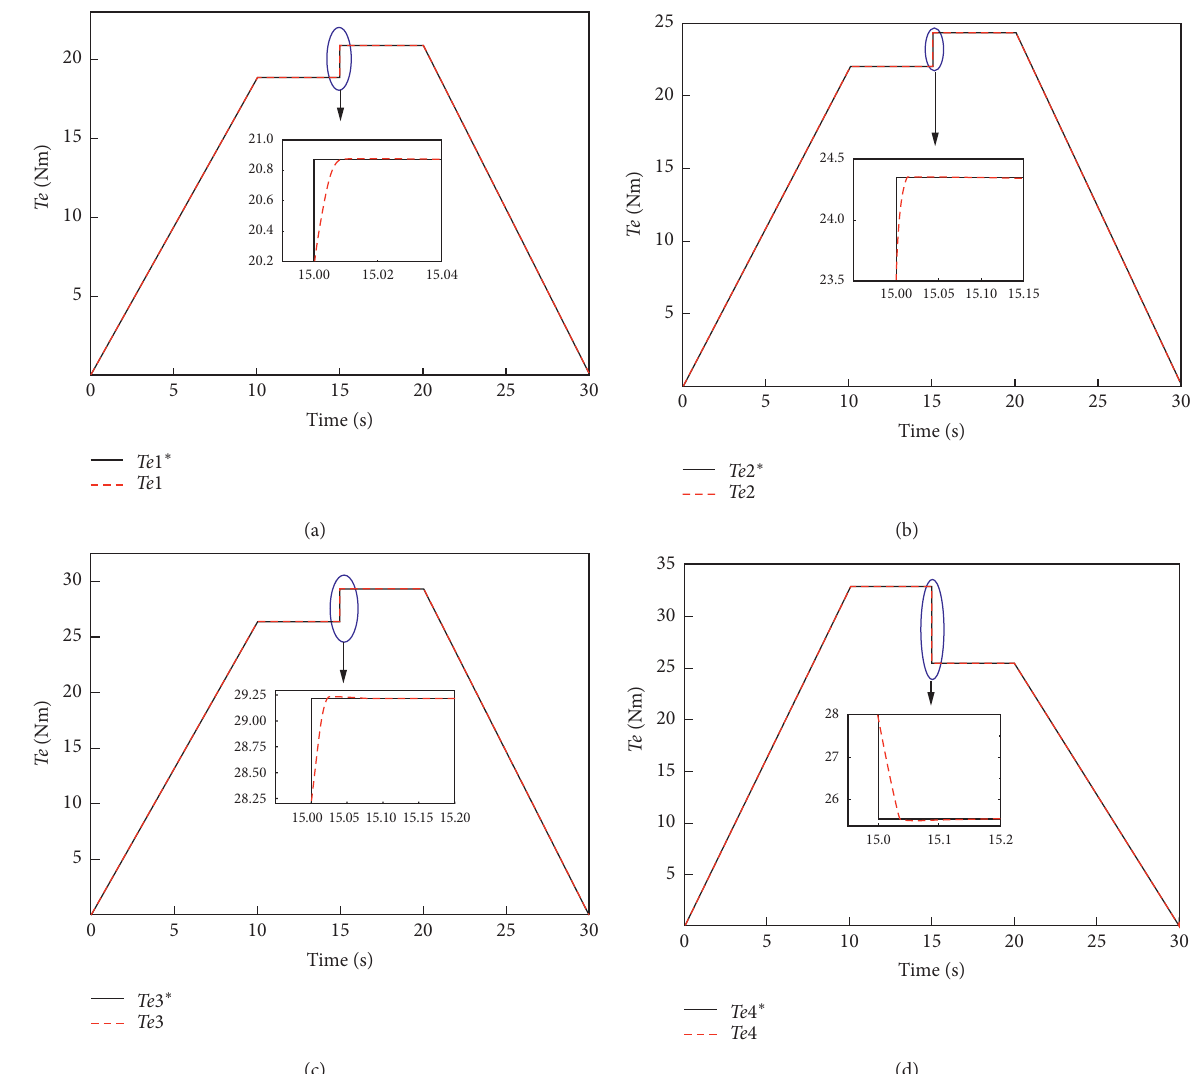
Figure 6: Output torque change curve of the four motors when the fourth motor loses 30% traction. (a) Output torque change curve of motor 1. (b) Output torque change curve of motor 2. (c) Output torque change curve of motor 3. (d) Output torque change curve of motor